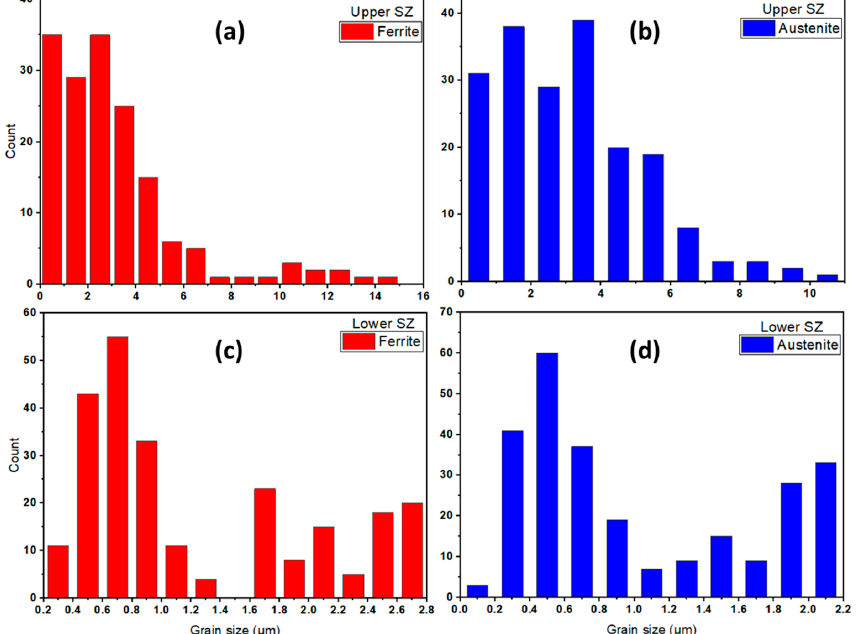
Figure 9. ( a ) Ferrite and ( b ) austenite grain size distribution histograms of the upper zone, and ( c ) ferrite and ( d ) austenite grain size distribution histograms for 2205 DSS butt joint welded at 300 rpm, 25 mm/min, and 20 KN.